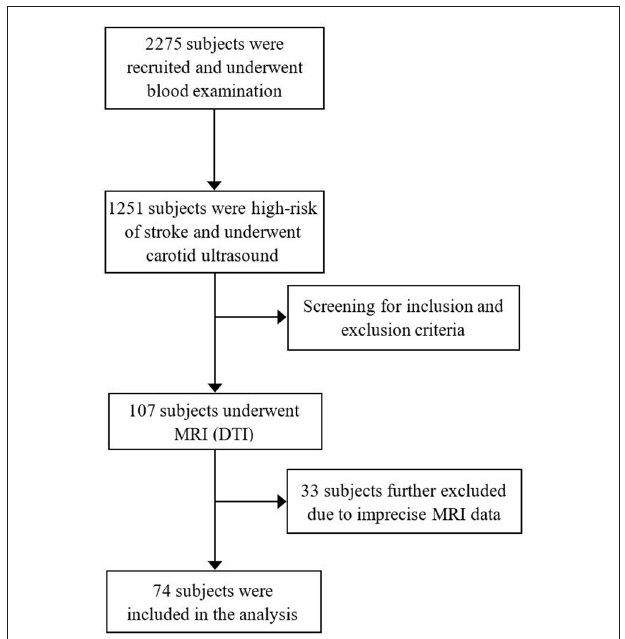
FIGURE 1 | Procedure for checking the enrolled population.